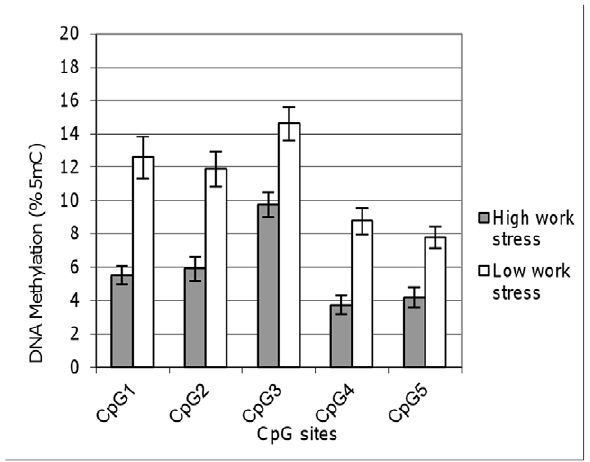
Figure 2. Methylation in the promoter of SLC6A4 at five CpG sites in high (grey) and low (white) work stress environments. Coordinates for each residue are 28 563 120 (CpG5), 28 563 109 (CpG4), 28 563 107 (CpG3), 28 563 102 (CpG2), and 28 563 090 (CpG1) as per GRCh37 build (NCBI Reference Sequence: NC_000017.10). Differences between work stress environments were significant as per t-test (p = 7.10E–06, p = 2.50E–05, p = 0.000292, p = 4.37E–06, and p=0.000289 respectively). Standard errors are indicated.